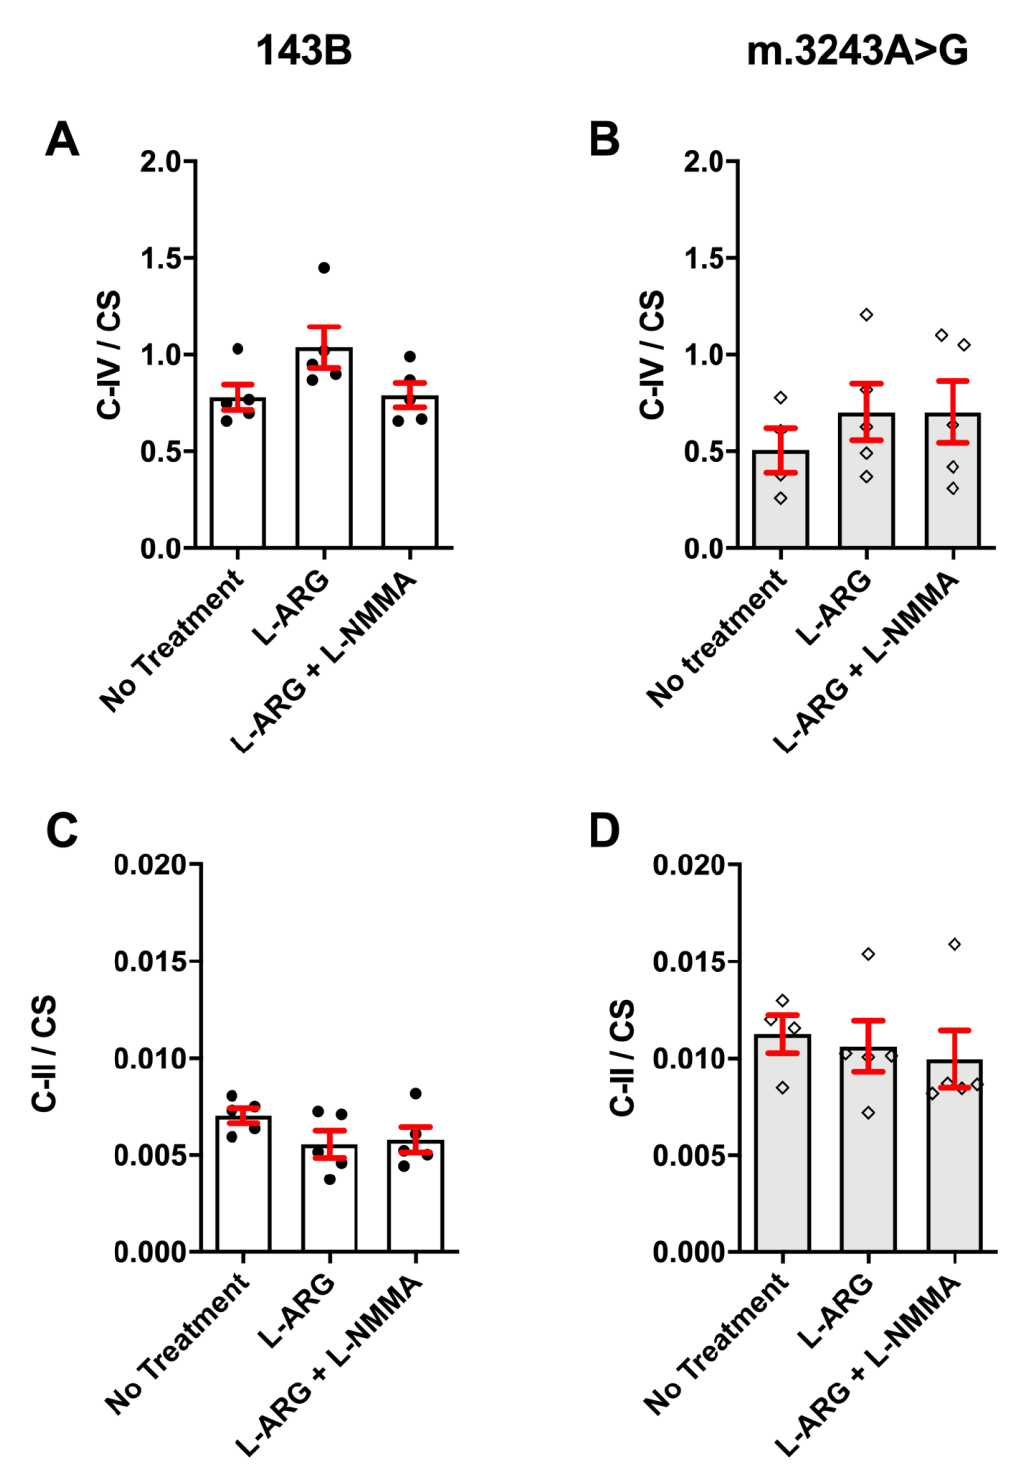
Figure 1. Mitochondrial enzyme activities measured by spectrophotometry. Mitochondrial enzyme activities were corrected to mitochondrial content using Citrate Synthase (CS) in 143B ( A , C ) and m.3243A>G ( B , D ) cells. No significant differences were found in C-IV and C-II with the three conditions (no treatment, L-ARG and L-ARG + L-NMMA) and in both cell types (m.3243A>G or 143B). Statistical analysis was performed using two-way ANOVA followed by Tukey’s Post Hoc test. C-II = Complex II; C-IV = Complex IV; CS = citrate synthase.